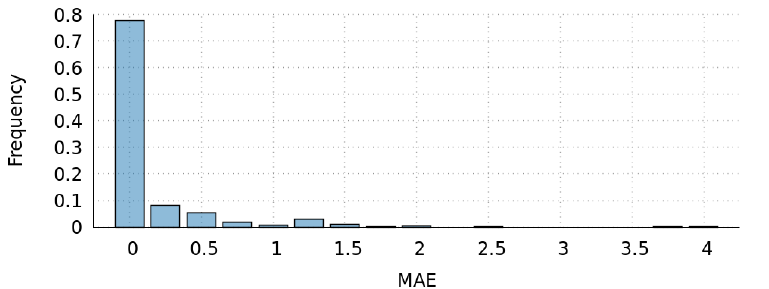
Figure 12. Histogram of the RBR Mean Absolute Error